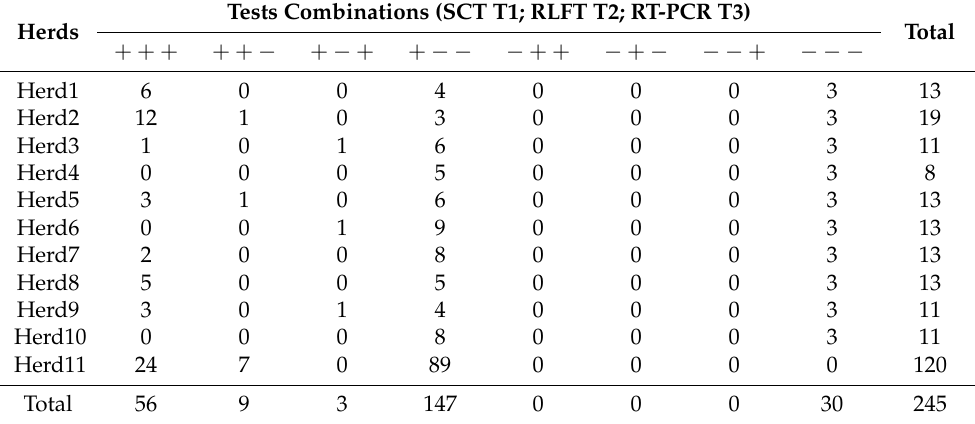
Table 2. Cross-tabulated findings for combinations of the three diagnostic tests (single cervical tuberculin test (SCT), rapid lateral-flow test (RLFT) and Real-Time PCR (RT-PCR)) for diagnosis of bovine tuberculosis in dairy cattle ( n = 245) from 11 Egyptian cattle herds. Tests Combinations (SCT T1; RLFT T2; RT-PCR T3) Herds